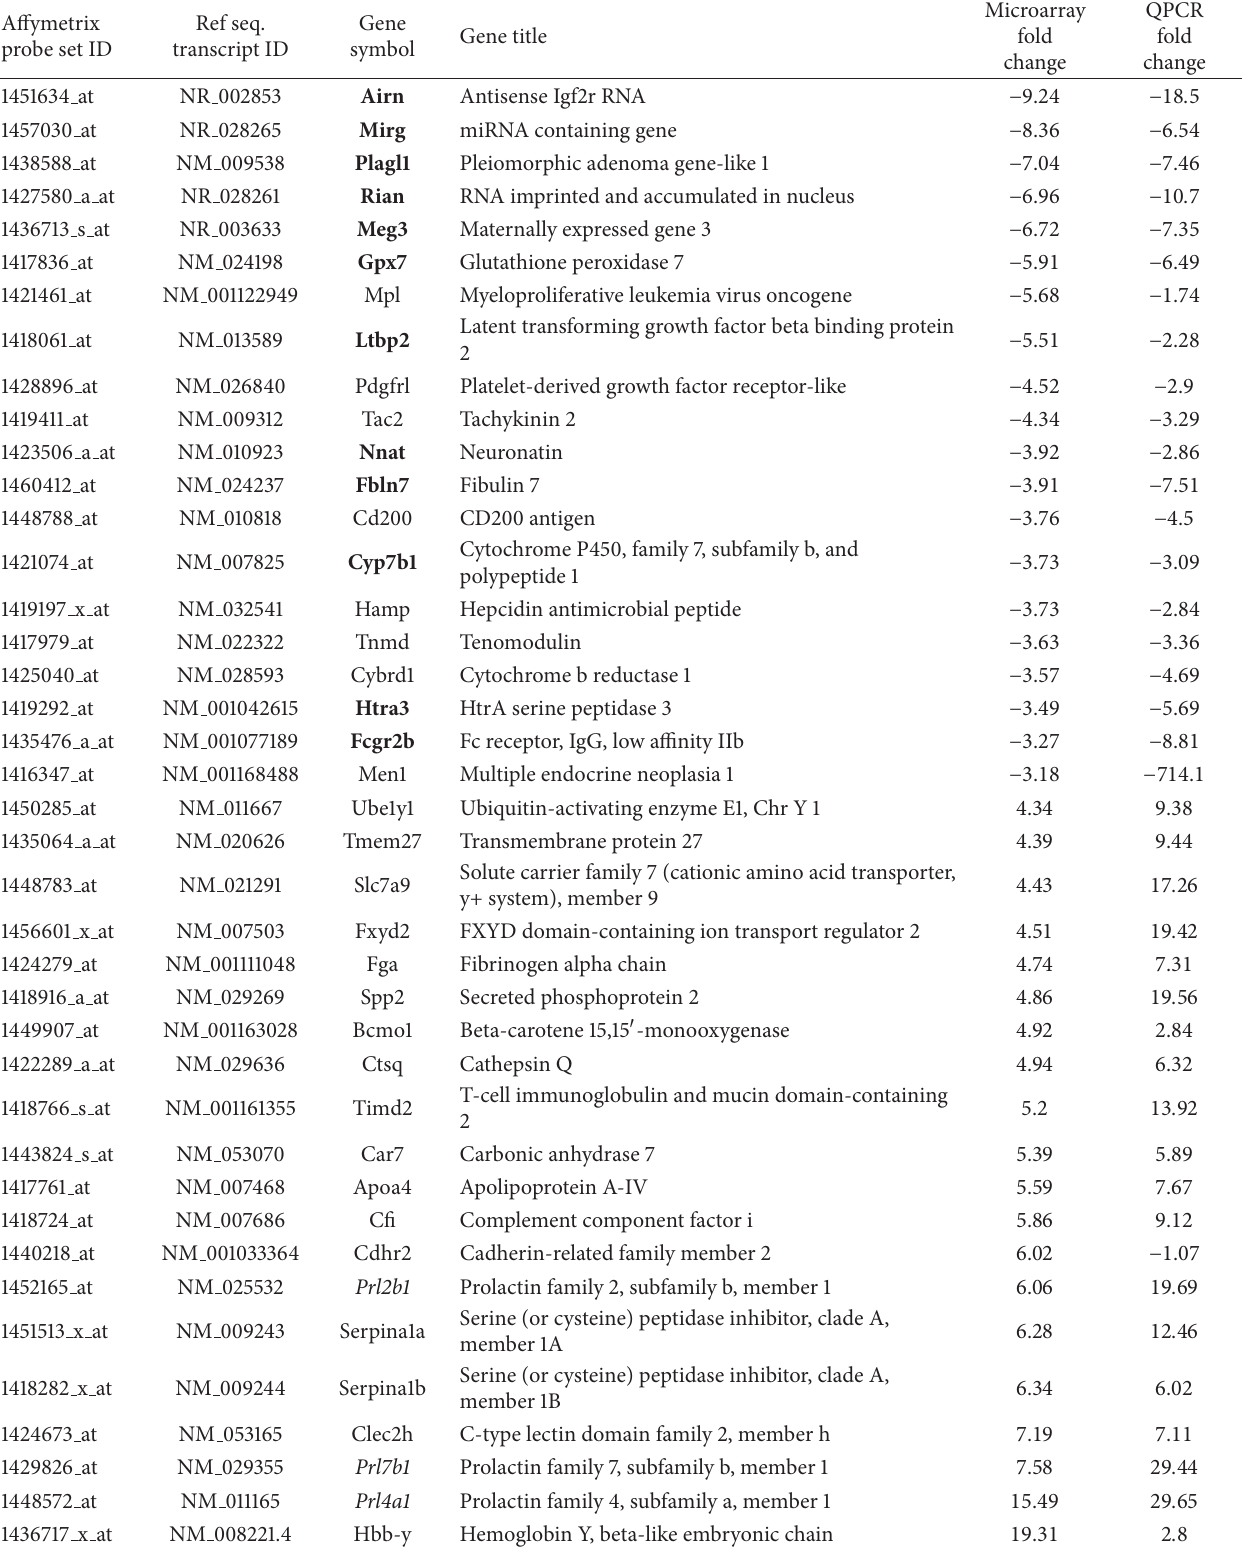
Table 1: Differentially regulated genes in Men1-KO versus WT adipocytes derived from